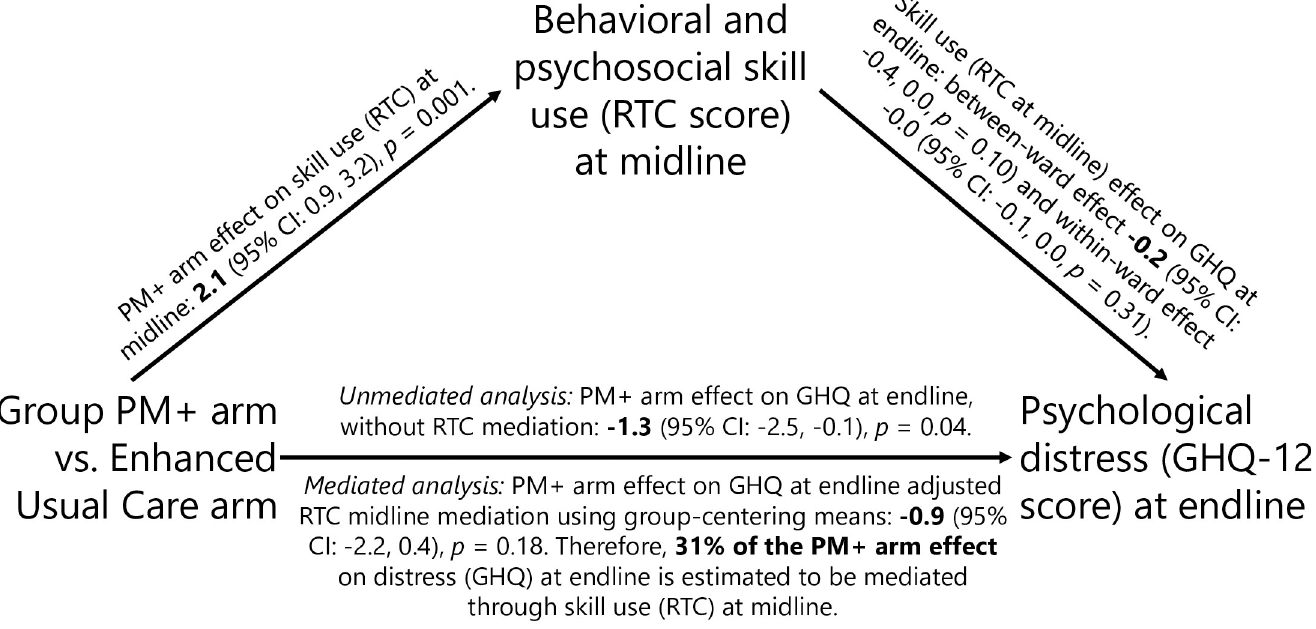
Fig 3. Hypothesized pathway with model-estimated effects for mediation of behavioral and psychosocial skill use at midline on psychological distress at endline. Midline is 7 weeks post-baseline (after completion of the intervention in the Group PM+ arm). Endline is 20 weeks post-baseline (approximately 3 months after completion of the intervention in the Group PM+ arm). GHQ-12, General Health Questionnaire; PM+, Problem Management Plus; RTC, Reducing Tension